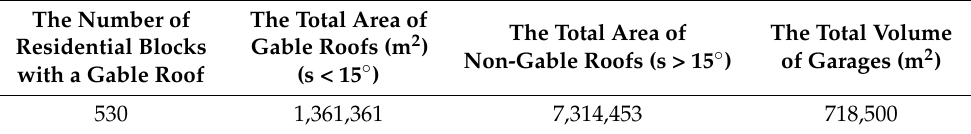
Table 3. The area of ceilings required and the volume of garages.